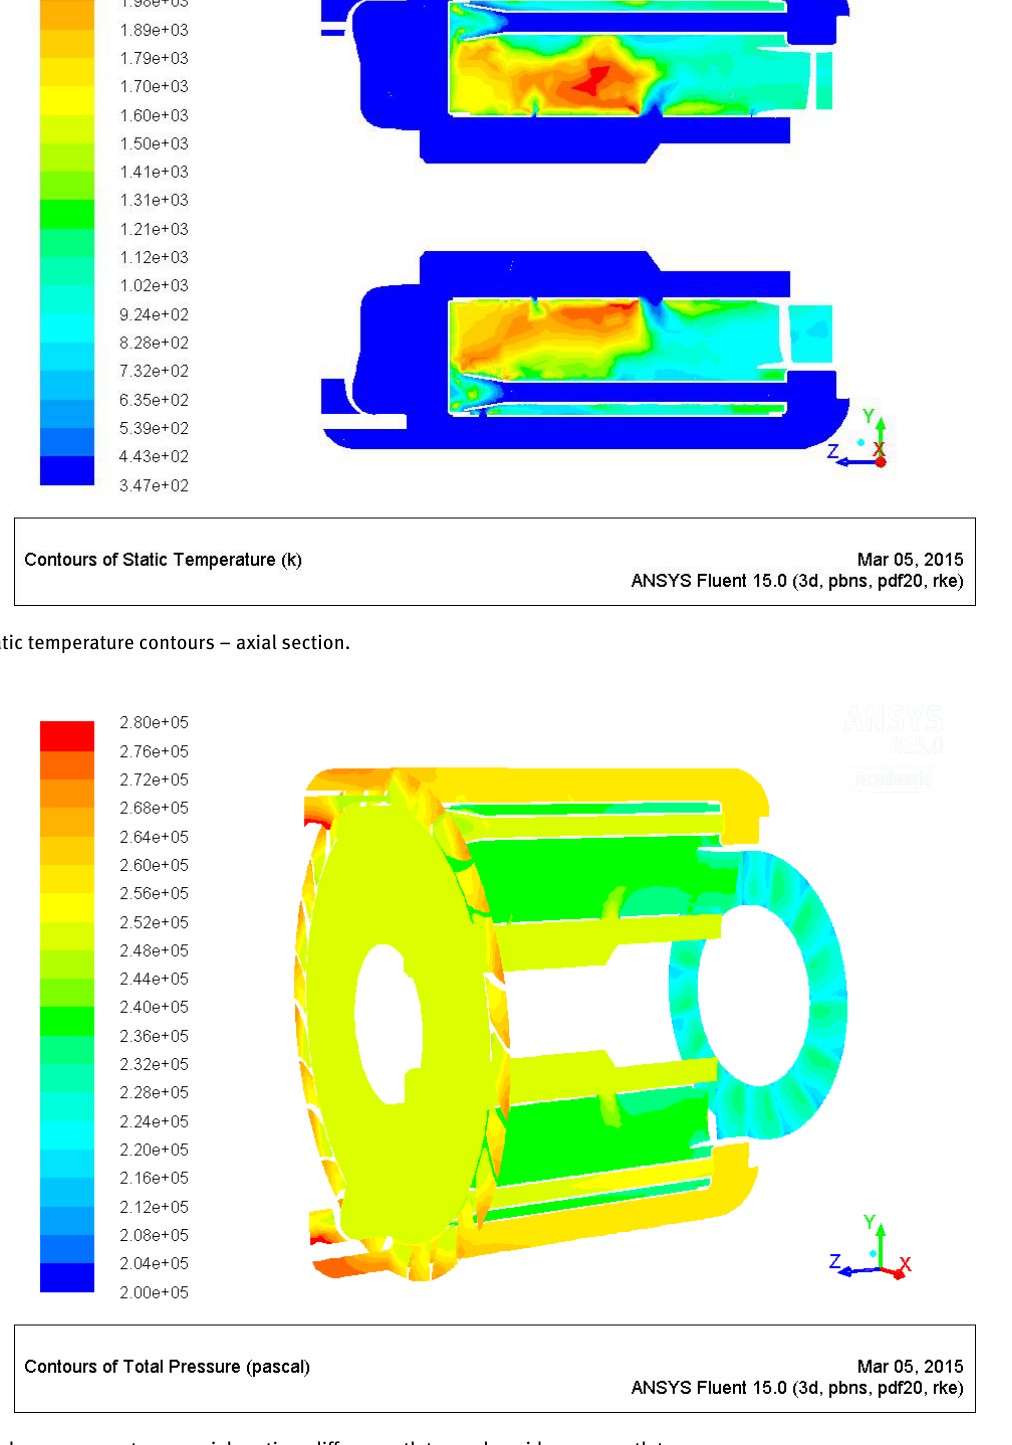
Figure 7: Total pressure contours - axial section; diffuser outlet; nozzle guide vanes